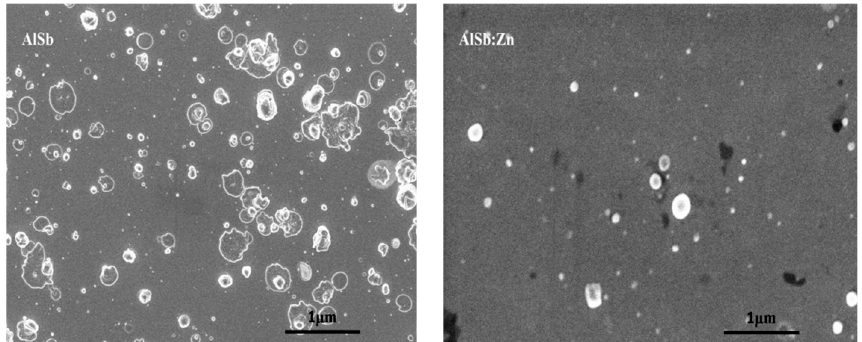
Figure 8. SEM images of AlSb and AlSb:Zn thin films stored in a vacuum chamber for 48 h.